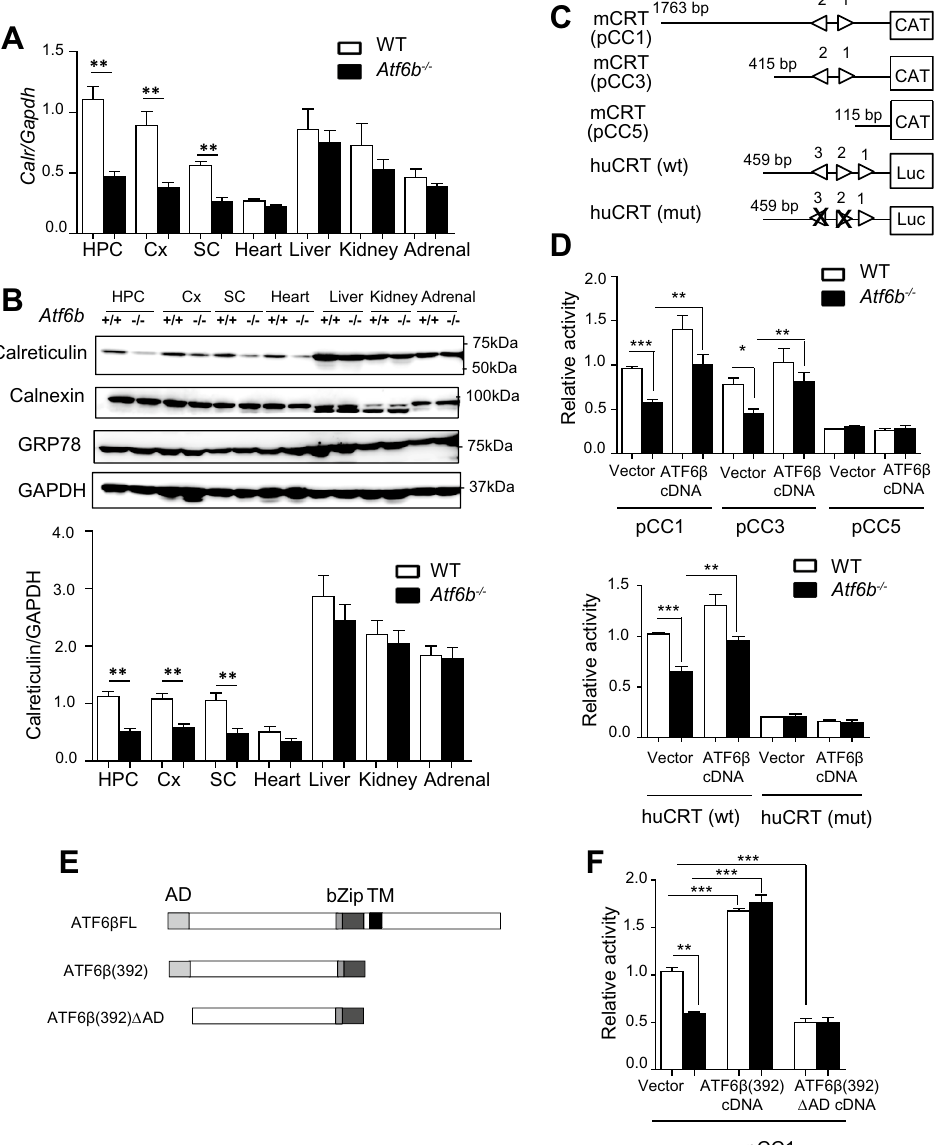
Figure 2. CRT expression in the WT and Atf6b −/− mice. ( A ) Expression of Calr mRNA in WT and Atf6b −/− tissues. Total RNA was isolated from the indicated tissues of each mouse and qRT-PCR was performed. n = 5 mice. Data are shown as mean ± SEM. **p < 0.01 by the Mann–Whitney U test. HPC hippocampus, Cx cerebral cortex, SC spinal cord. ( B ) Expression of CRT protein in WT and Atf6b −/− tissues. Protein samples were extracted from the indicated tissues of WT and Atf6b −/− mice, and subjected to western blotting. n = 5–7 mice. Data are shown as mean ± SEM. **p < 0.01 by the Mann–Whitney U test. ( C ) Schematic Representation of the promoters used. Triangles indicate the locations and orientations of ERSE motifs that completely or considerably match the consensus CCAATN9CCACG 18 . Numbers indicate nucleotide positions from transcription start site. ERSE2 and ERSE3 of the human CRT promoter were disrupted by mutating their sequences (marked by crosses). ( D ) Reporter assays using cultured hippocampal neurons. The CAT ELISA and luciferase assay were performed using cells transfected with the mouse CRT promoters, pCC1, pCC3, and pCC5 (upper graph), or with the human CRT promoters, huCRT(wt) and huCRT(mt) (lower graph). n = 4. Data are shown as mean ± SEM. *p < 0.05, **p < 0.01, ***p < 0.001, by a two-way ANOVA followed by the Bonferroni test. ( E ) Schematic Representation of the full-length (FL), the active form (392) and the dominant-negative form ((392)∆AD) of ATF6β 14 . AD activation domain, bZip the basic leucine zipper domain, TM transmembrane domain. ( F ) Reporter assays using cultured WT and Atf6b −/− hippocampal neurons. The CAT ELISA assay was performed using cells transfected with the mouse CRT promoter pCC1. n = 3–5 experiments. Data are shown as mean ± SEM. **p < 0.01, ***p < 0.001, by a two-way ANOVA followed by the Bonferroni